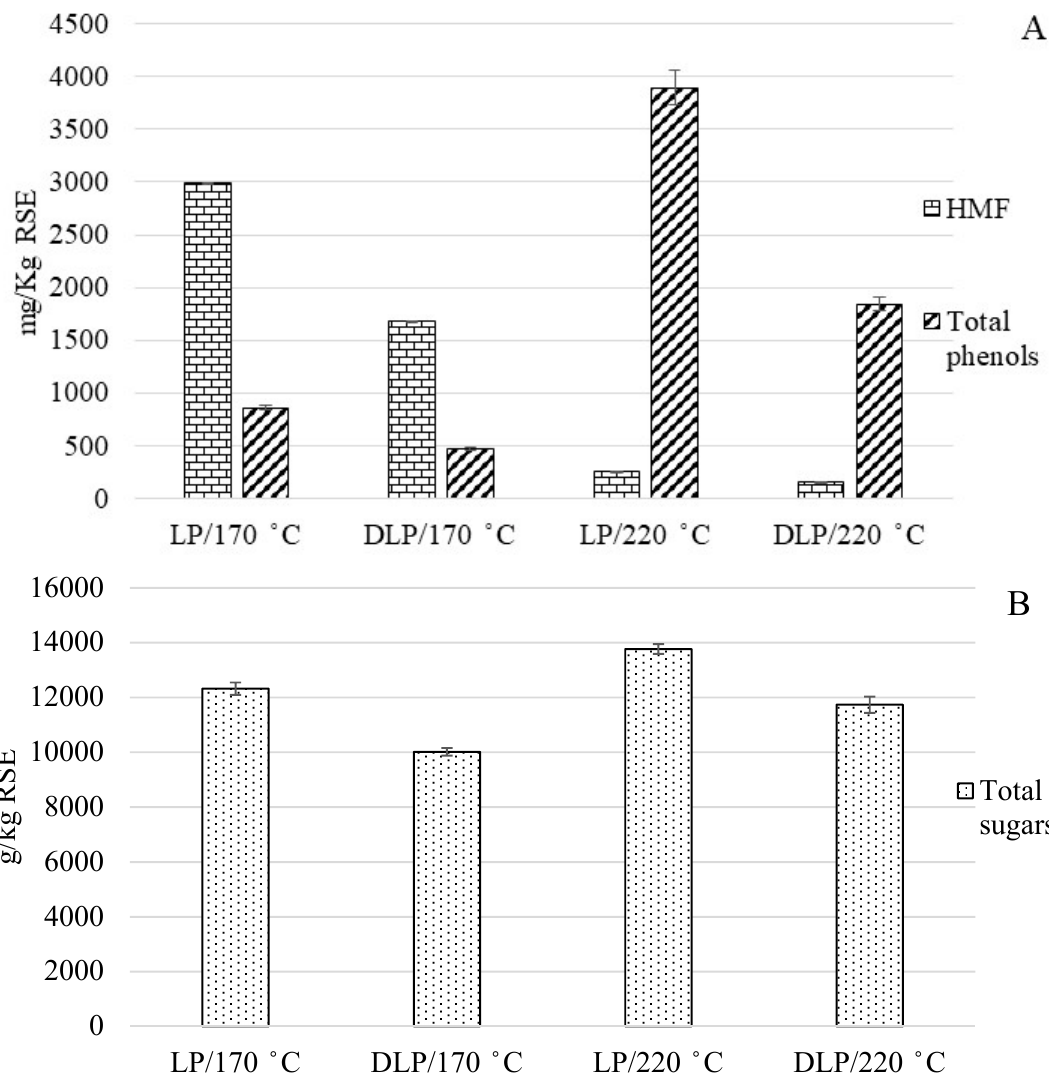
Figure 1. ( A ) Total phenols, hydroxymethylfurfural (HMF), and ( B ) total sugars from the liquid phase (LP) and the dephenolized liquid phase (DLP) after extraction of phenolic compounds with their standard deviations; where RSE, residual strawberry extrudate.